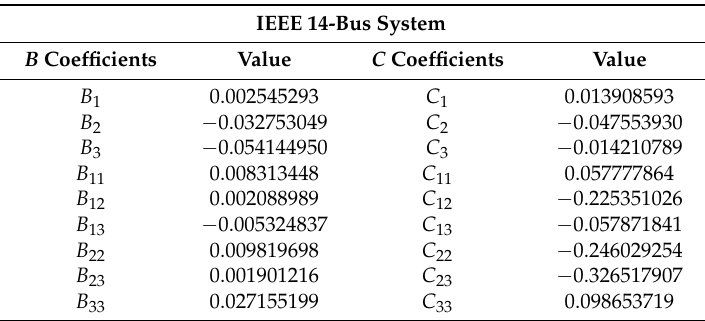
Table 1. New Loss Coefficients of the IEEE 14-bus system.